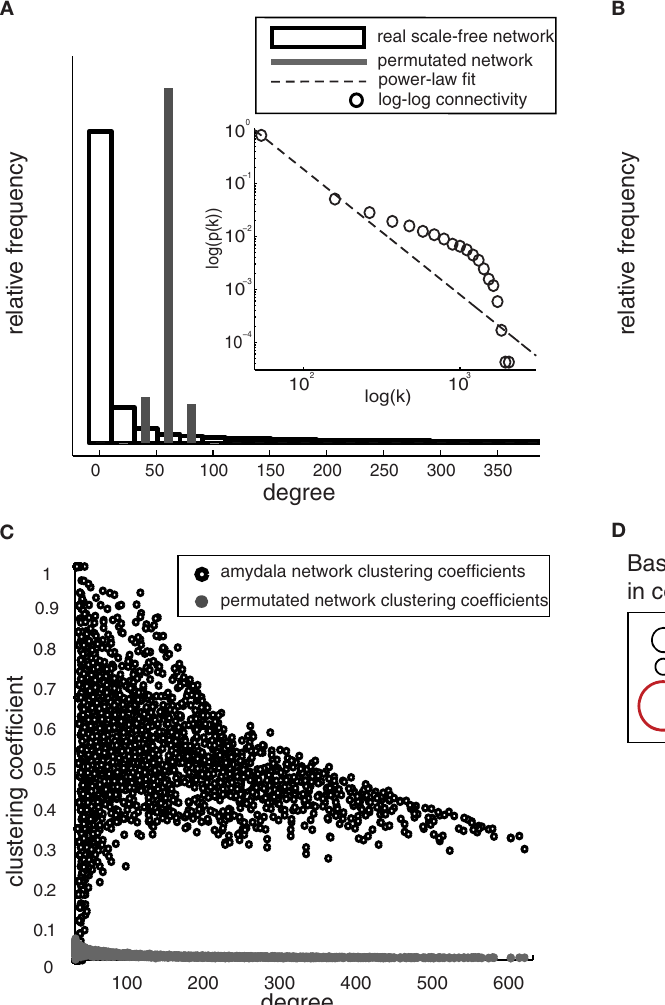
Table 1 . (D) Network schematic of resilient structure, which persists in both control and disease networks, showing existence of hubs, high clustering, and positive